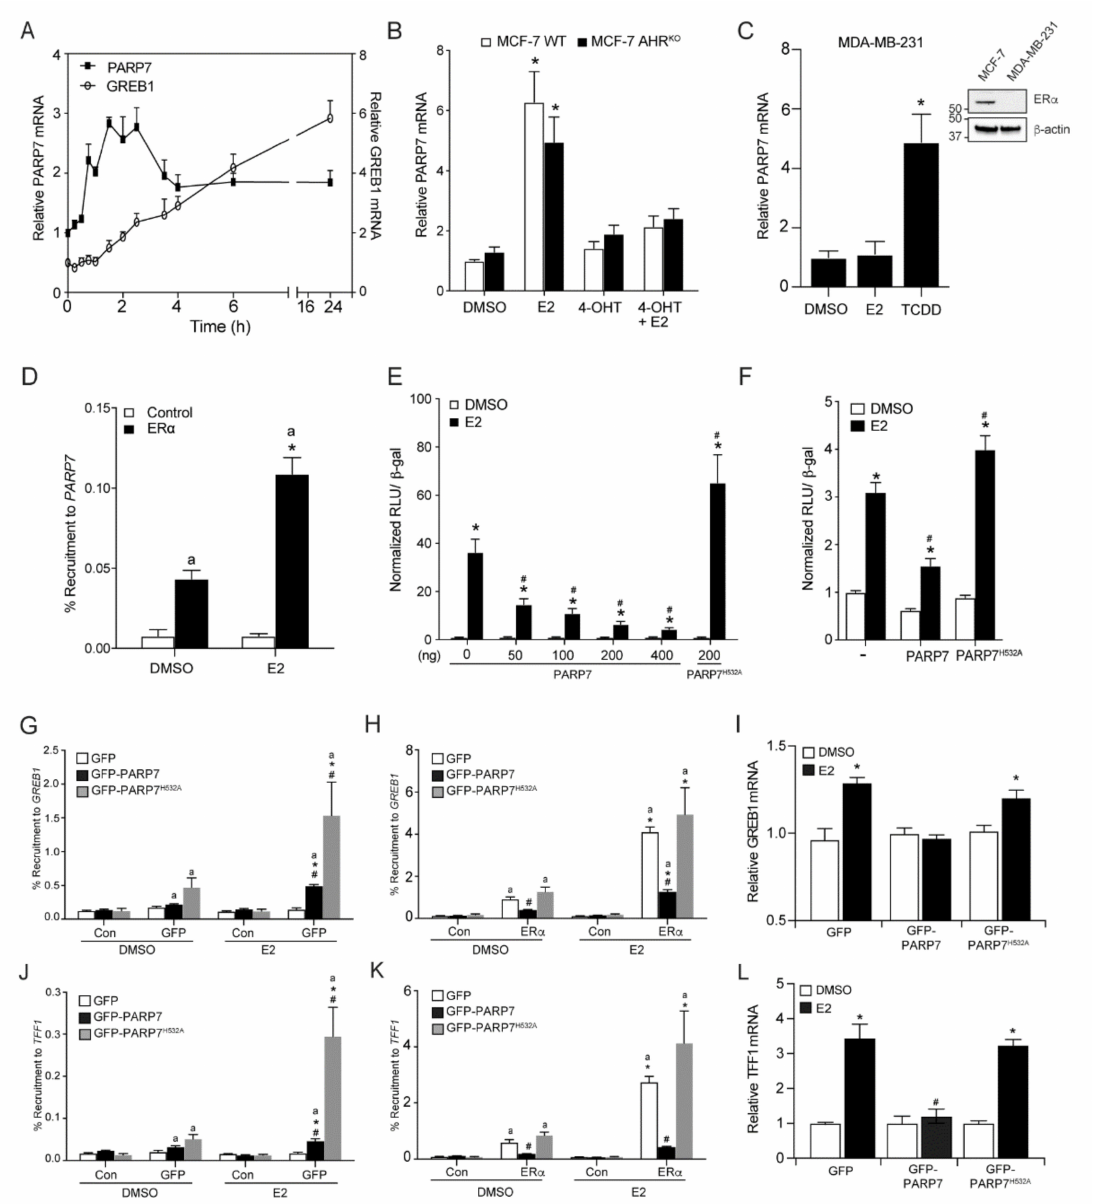
Figure 1. PARP7 is a target gene and repressor of ER α ( A ) PARP7 expression is induced by E2. MCF-7 cells were treated with E2, and RNA was isolated at various time points ranging from 15 min to 24 h. The relative mRNA levels of PARP7 (left axis) and GREB1 (right axis) were determined with RT-qPCR. ( B ) PARP7 is an ER α target gene and its expression is regulated by ER α , independent of AHR. MCF-7 wildtype and AHR KO cells were treated with 0.1% DMSO, 10 nM E2 or/and 100 nM 4-OHT for 2 h. The co-treated samples were treated with 4-OHT 2 h prior to E2 treatment. The relative mRNA levels were determined with RT-qPCR. The asterisk * denotes significant differences ( p < 0.05) from DMSO. ( C ) PARP7 mRNA levels in MDA-MB-231 cells treated with 0.1% DMSO, 10 nM E2 or 10 nM TCDD for 2 h. Insert western blot of ER α levels in MCF-7 compared with MDA-MB-231 cells. The asterisk * denotes significant differences ( p < 0.05) from DMSO. ( D ) ER α is recruited to the PARP7 promoter in an E2-dependent manner. Wildtype MCF-7 cells were treated with 0.1% DMSO or 10 nM E2 for one hour. The letter “a” denotes recruitment differences significantly greater than the control ( p < 0.05), and significant differences ( p < 0.05) from DMSO is denoted with the asterisk *. PARP7, but not the catalytically inactive H532A mutant, repressed ER α -regulated reporter gene activity. ( E ) HuH-7 or ( F ) MCF-7 cells were transfected with ERE-TK-Luc reporter, pSG5-ER α , β -galactosidase, PARP7, or the catalytically inactive mutant. Six hours after transfection, cells were treated with 0.1% DMSO or 10 nM E2 for 18 h. Changes in reporter gene activity are shown as normalized relative light units